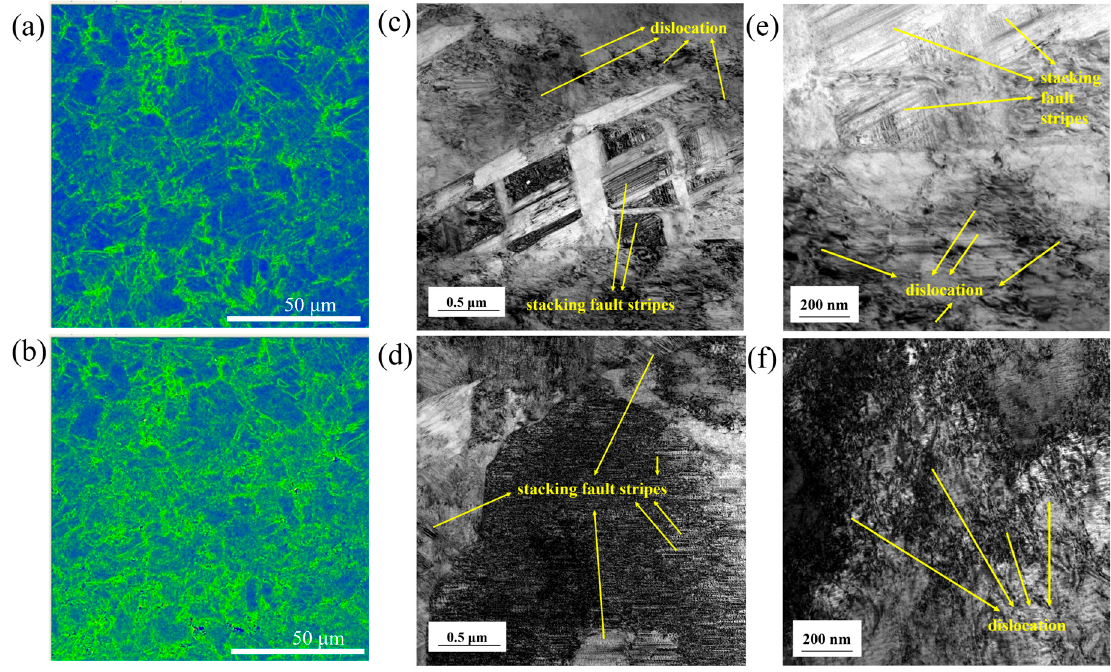
Figure 5. KAM maps of bulk Co and bright-field TEM images. ( a ) UT; ( b ) 1T; ( c , e ) UT; ( d , f )